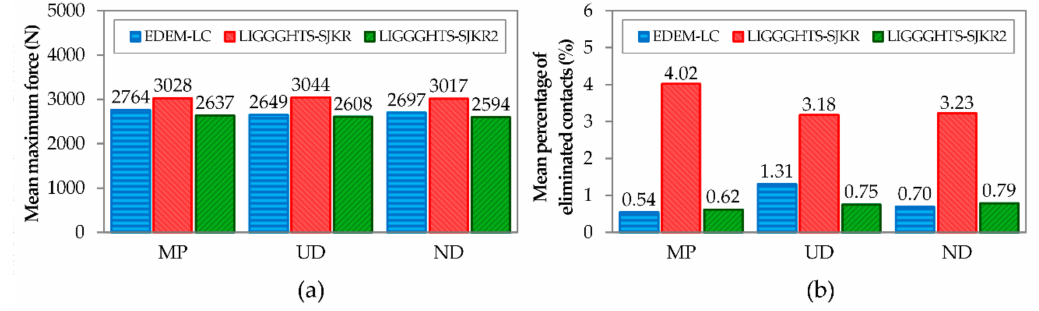
Figure 8. Mean values of ( a ) the maximum force and ( b ) the percentage of eliminated